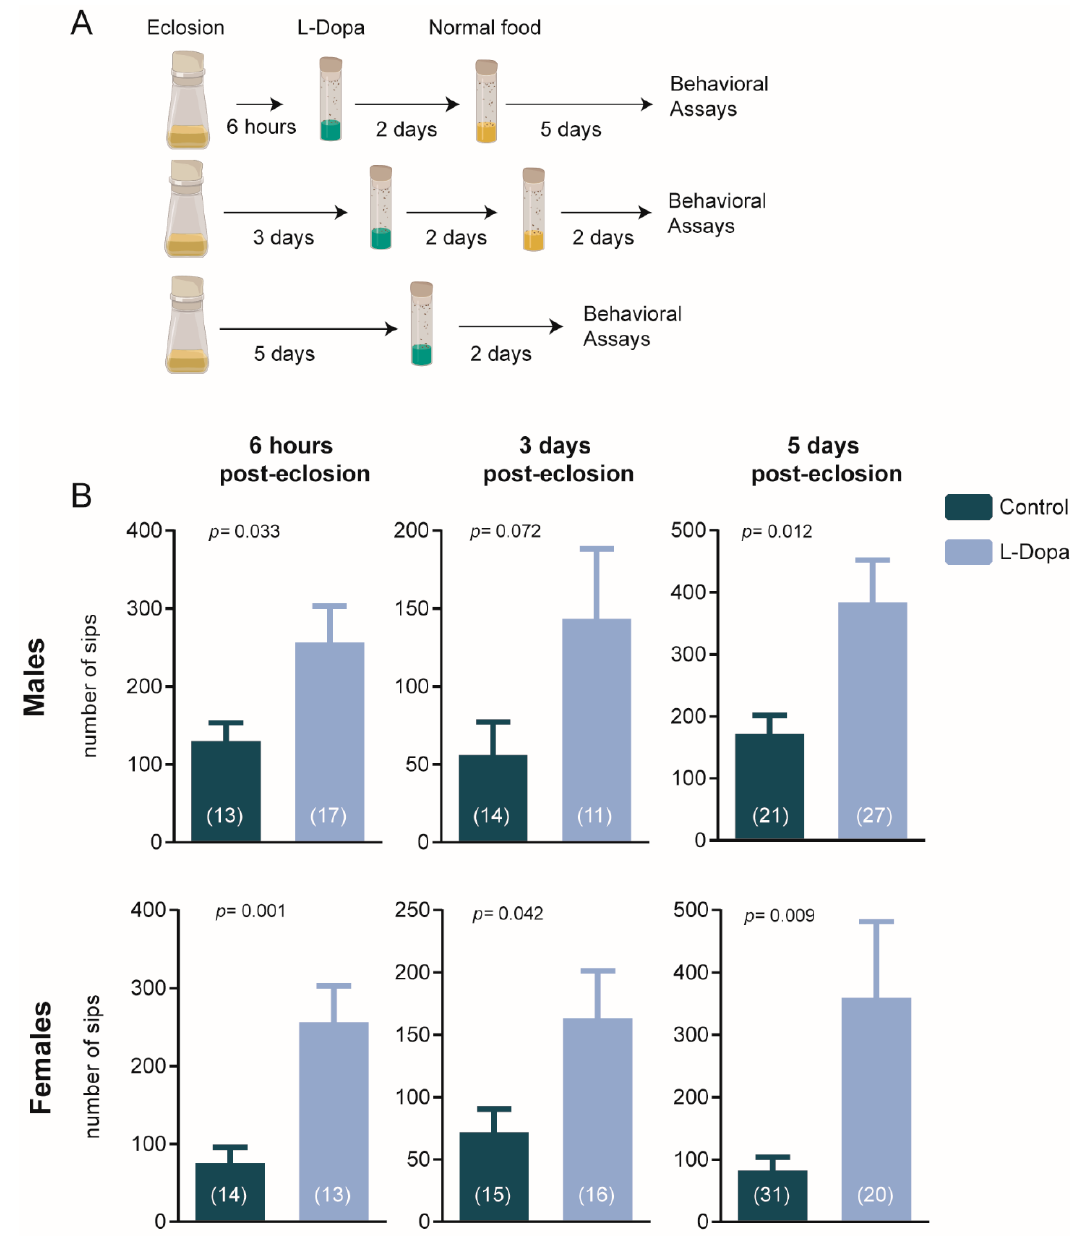
Figure 1. Dopaminergic administration induces overeating. ( A ) Before the behavioral testing at 7-days old, levodopa treatment was delivered in the food for 2 days to 6 h, 3 days or 5 days post-eclosion flies. ( B ) All groups showed increased feeding behavior after the transient dopaminergic manipulation, with only 3 days old -treated males slightly above statistical significance (Student t -test; alpha = 0.05). Bars and errors represent mean ± SEM, and the sample size for each group is given within brackets.